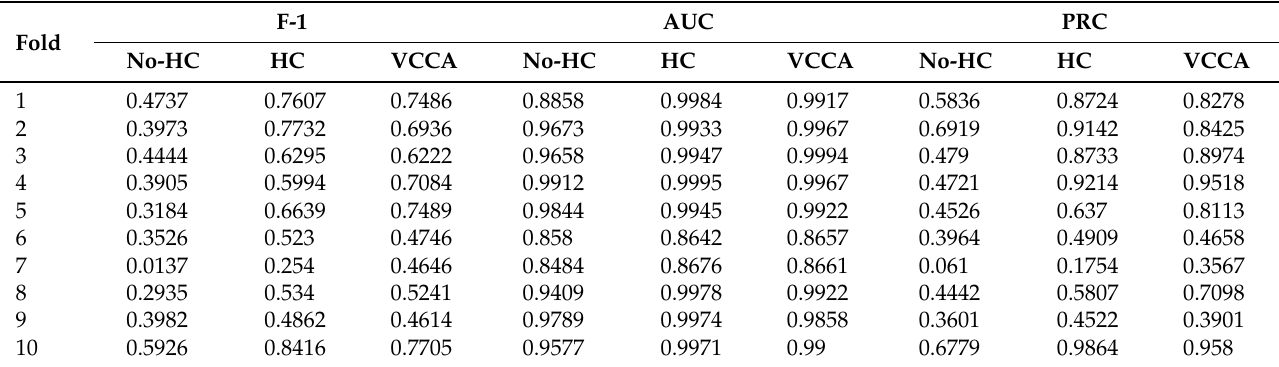
Table 5. The Mean of Metrics for Dataset